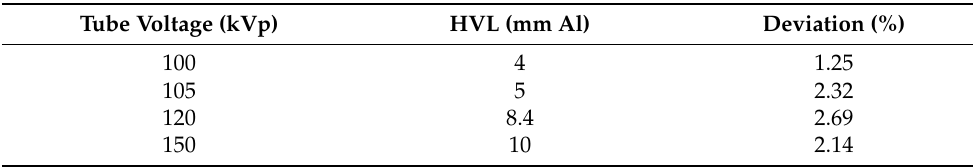
Figure 11. Relative response for 200 cm and 1 cm probe length under a wide range HVLs found in clinical routine. Data were normalized to RQT9 radiation quality. Table 4. Response deviation between the 1cm and the 200 cm PSF length for different radiation qualities in diagnostic range.